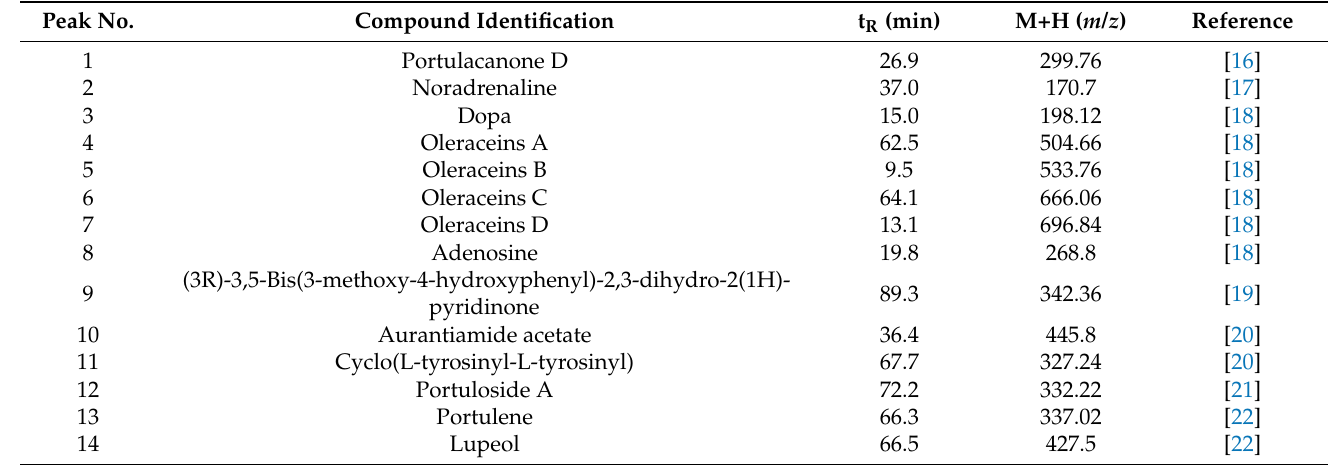
Table 1. The peak of chemicals in the hydroethanol extract of Portulaca oleracea , using positive mode